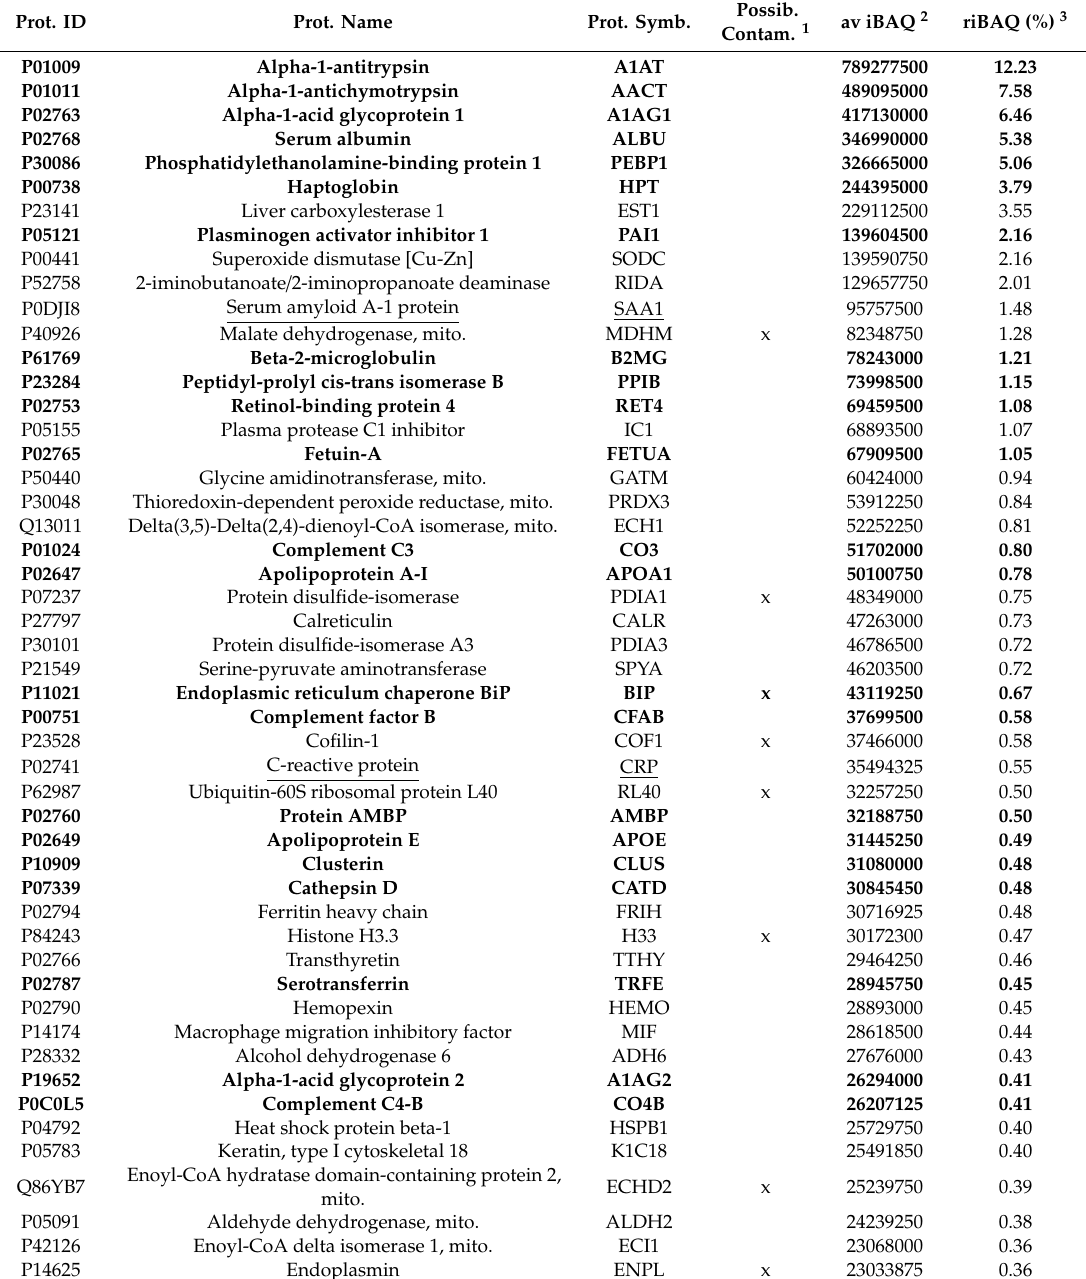
Table 2. PHH riBAQ list—top 50